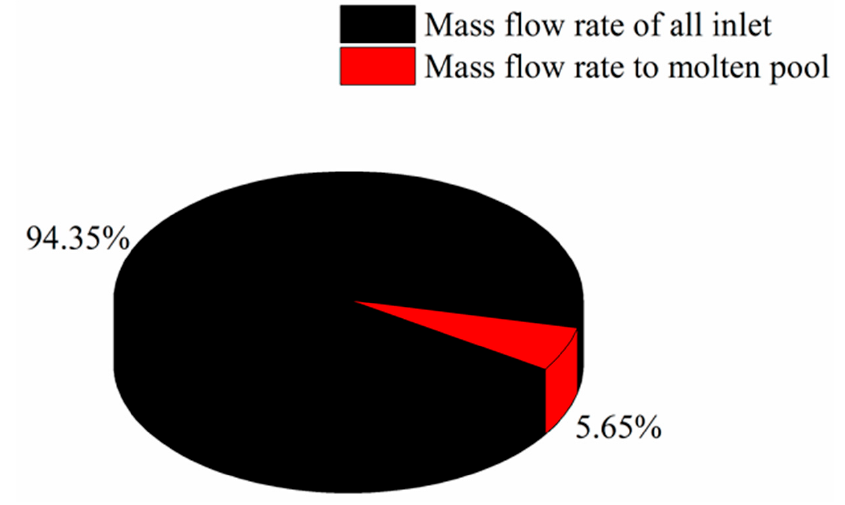
Figure 9. Mass flow rate statistics in the hybrid process.